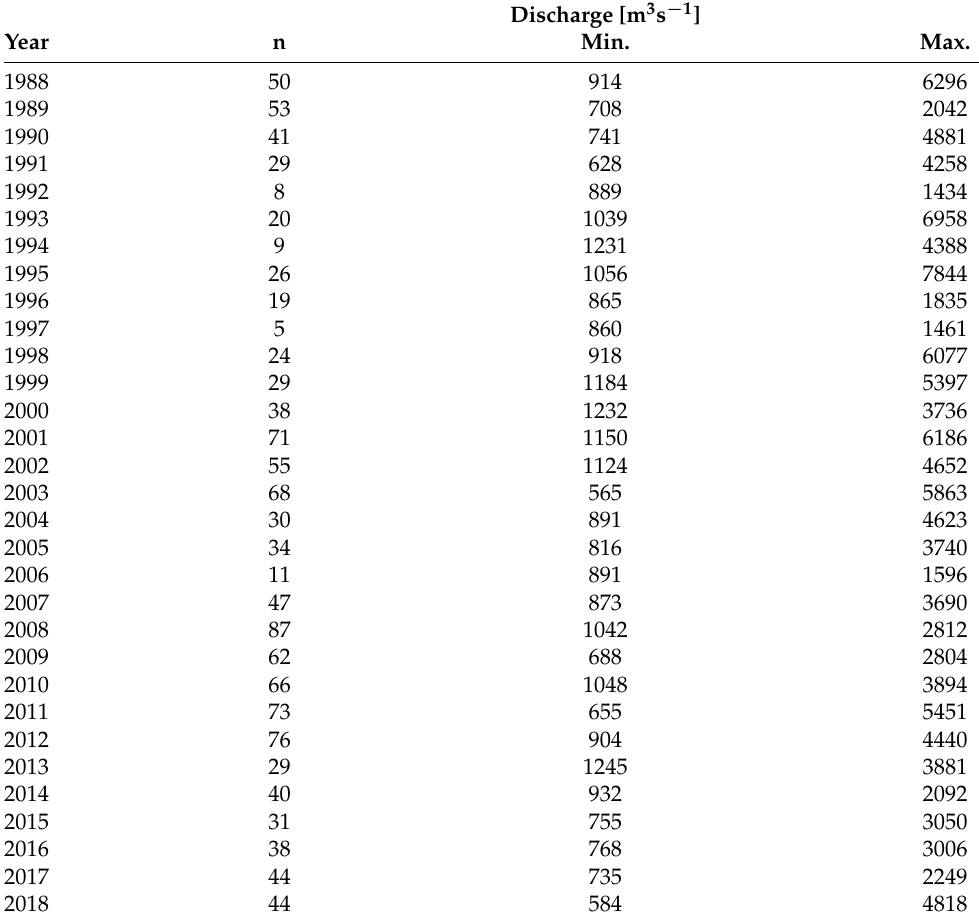
Table A2. Overview of discharge measurements from the hydraulic